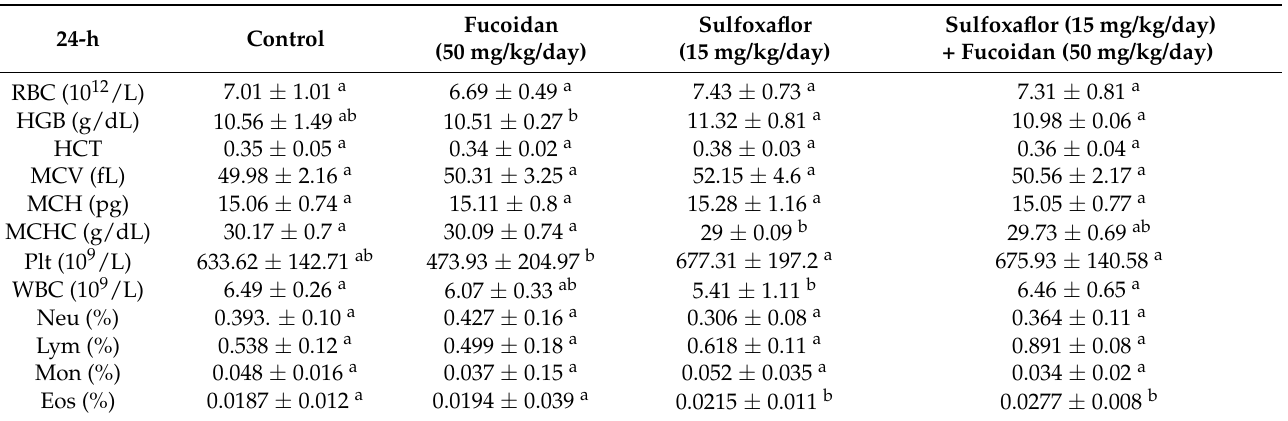
Table 1. Effects of sulfoxaflor and fucoidan on hematological parameters at 24-h treatment period in mice.